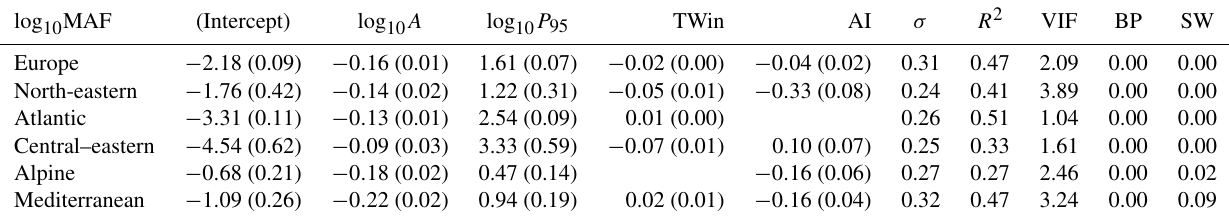
Table A1. Regression coefficients (standard errors), model error variance, R 2 , and maximum variance inflation factor (VIF) of regional regression models for MAF. The last two columns contain p values for the Breusch–Pagan (BP) and Shapiro–Wilk (SW) tests. Statistically significant results (small p values) indicate heteroscedasticity and non-normality of the residuals, respectively. All numbers are rounded to two digits. For details on VIF, see e.g. Weisberg (2005), and for details on the hypothesis tests, see e.g. Helsel et al. (2020).